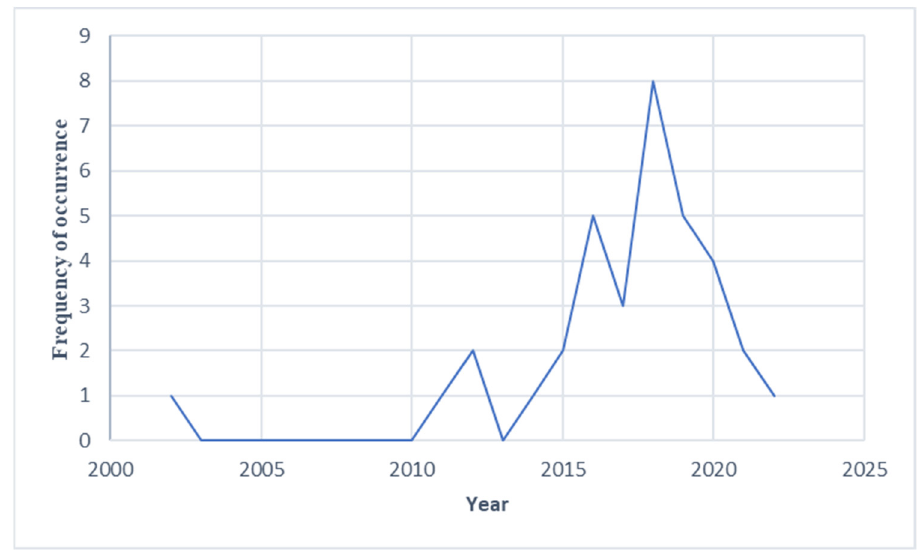
Figure 14. Study distribution of “chaos control” from 2002 to 2022.